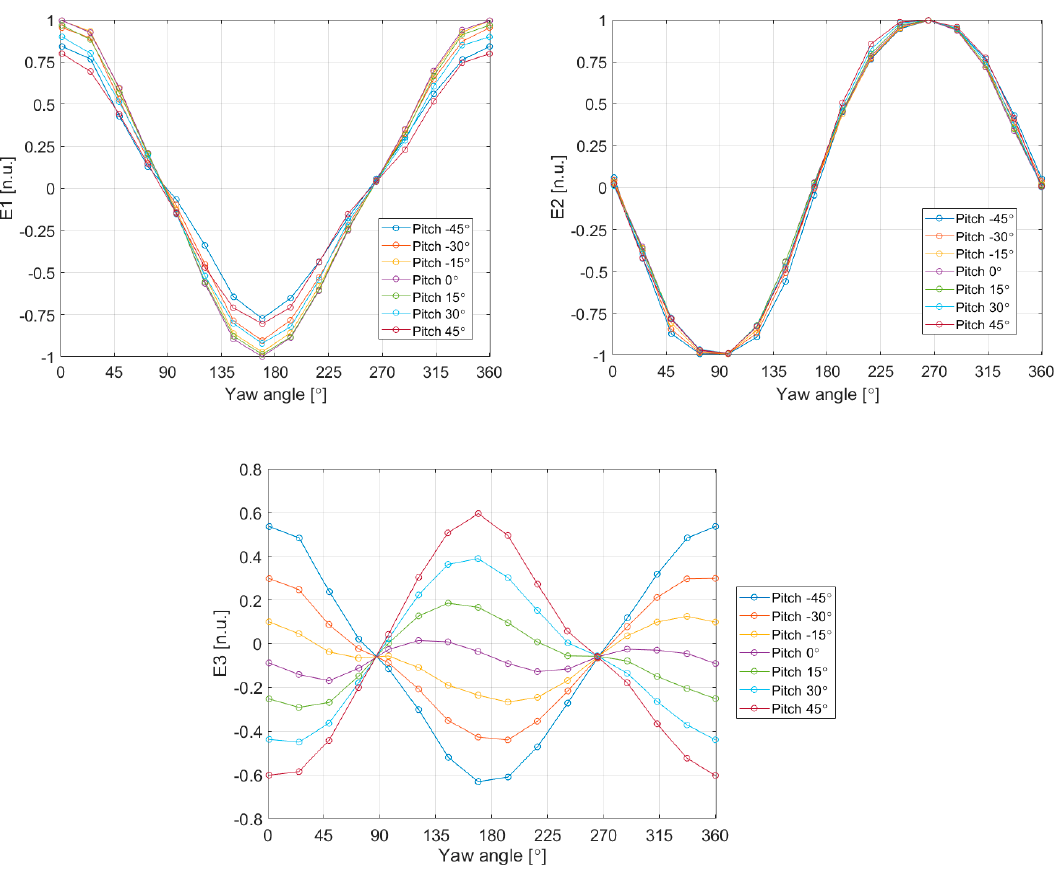
Figure 16. Estimators E1, E2, and E3 for the experiment reported in Figures 11 and 12, as a function of the yaw angle for seven different values of the pitch angle.